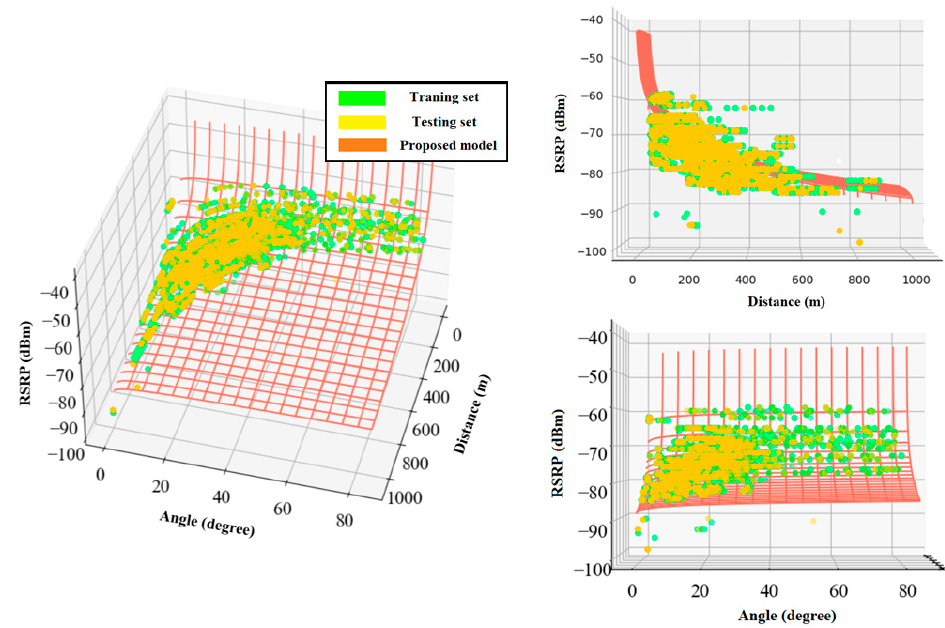
Figure 15. 3D representation of the proposed logarithmic model for RSRP.